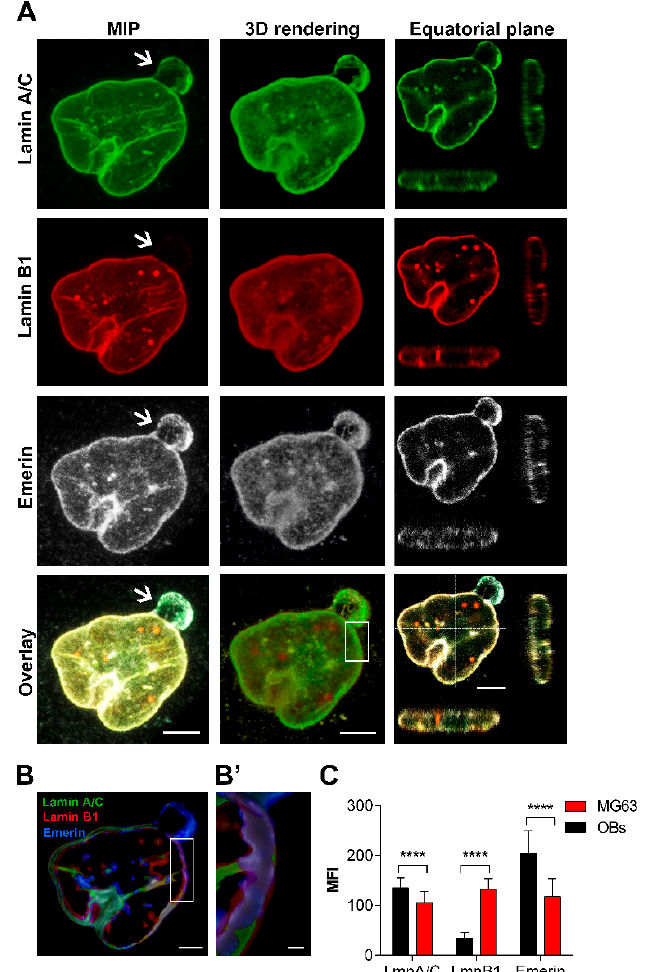
Figure 4. Behaviour of lamins and emerin, and nuclear morphology in MG63 cell line. ( A ) Maximum intensity projection (MIP) of series of z-stacks images covering the entire nucleus (left column), 3D rendering in blend volume mode (central column, LAS X 3D software, Leica Microsystems, Wetzlar, Germany), and XZ- and YZ-axes projections performed in the central focal plane of the nucleus (right column) are shown. Bars: 5 µ m. ( B ) 3D rendering in the focal central plans of the nuclear rim in surface volume mode (Imaris software). Bar: 3 µ m. ( B’ ) High magnification of the 3D rendering of the boxed area showing the differential expression of lamins (in green and red) and emerin (pseudocoloured in blue). Bar: 1 µ m. ( C ) Mean Fluorescence Intensity (MFI) of lamins and emerin immunoexpression in MG63 cells, in comparison to normal OBs. ****: p < 0.001.